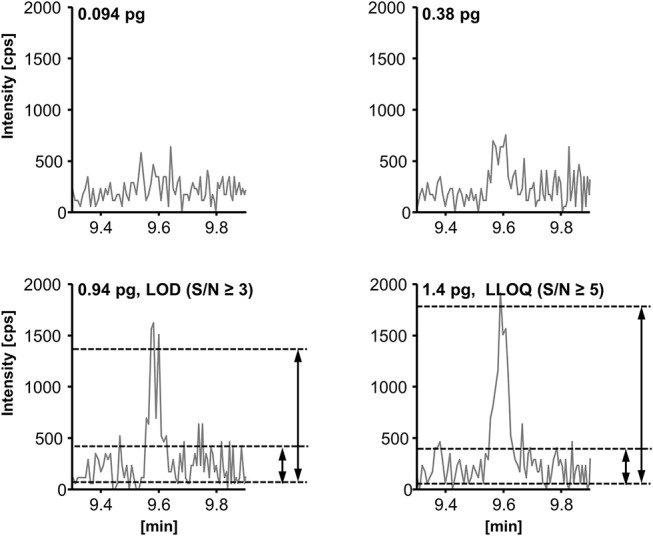
Determination of the limit of detection (LOD) and the lower limit of quantification (LLOQ) exemplarily shown for resolvin D2 (RvD2, m/z 375.3 → 175.0). LOD is defined as peak-to-peak signal-to-noise-ratio (S/N) ≥ 3 and LLOQ as (S/N) ≥ 5 and an accuracy within ±20% of the nominal concentration.